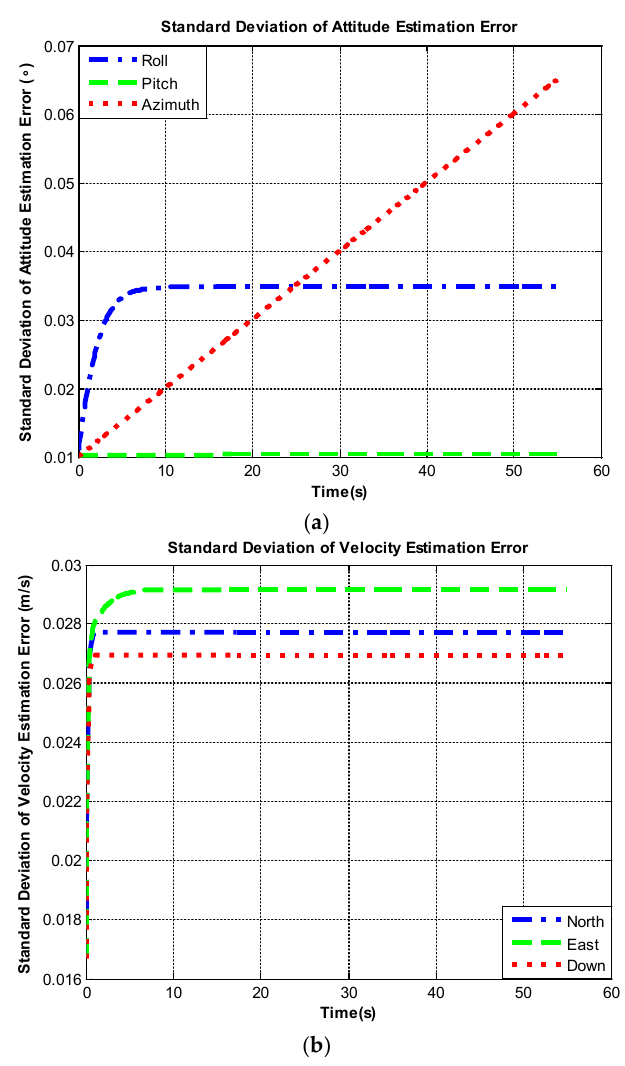
Figure 14. ( a ) Standard deviation attitude estimation error; and ( b ) standard deviation velocity estimation error.